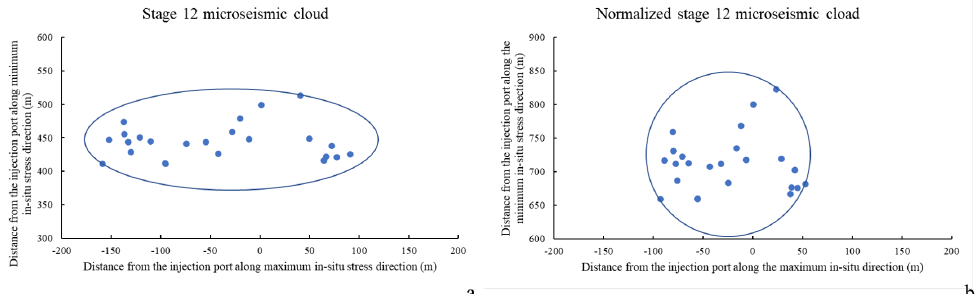
Figure 5. The planar microseismic event coordinates for stage 12 rotated to align with maximum in-situ stress direction and translated to be relative to injection port coordinates ( a ). The normalised stage 12 microseismic event coordinates using L max = 150 m, L min = 50 m, and L int = 75 m ( b